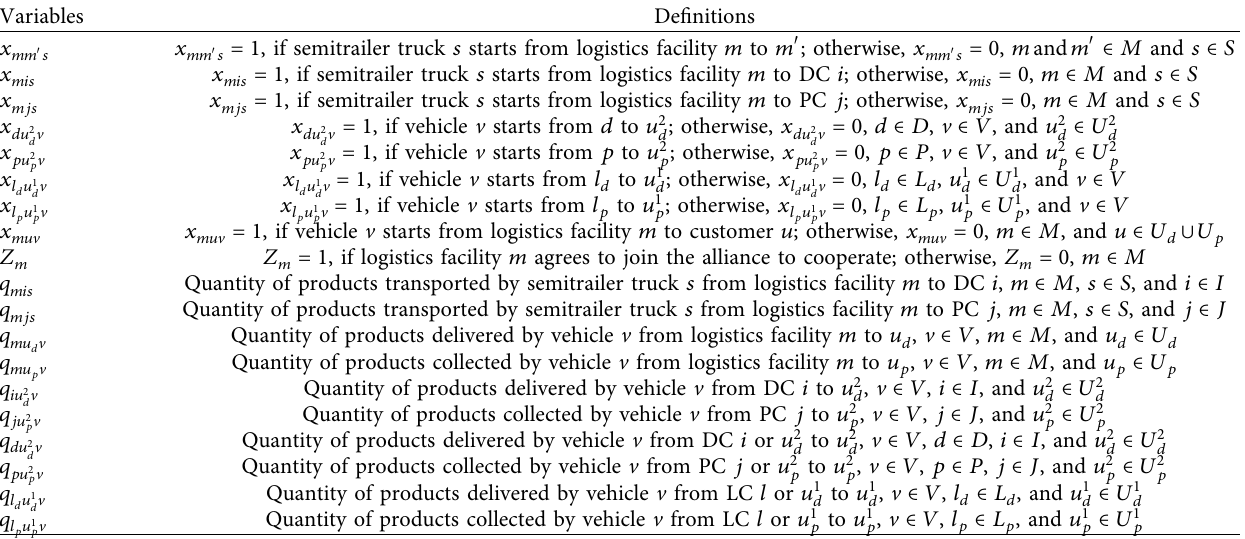
Table 4: Decision variables related to the mathematical